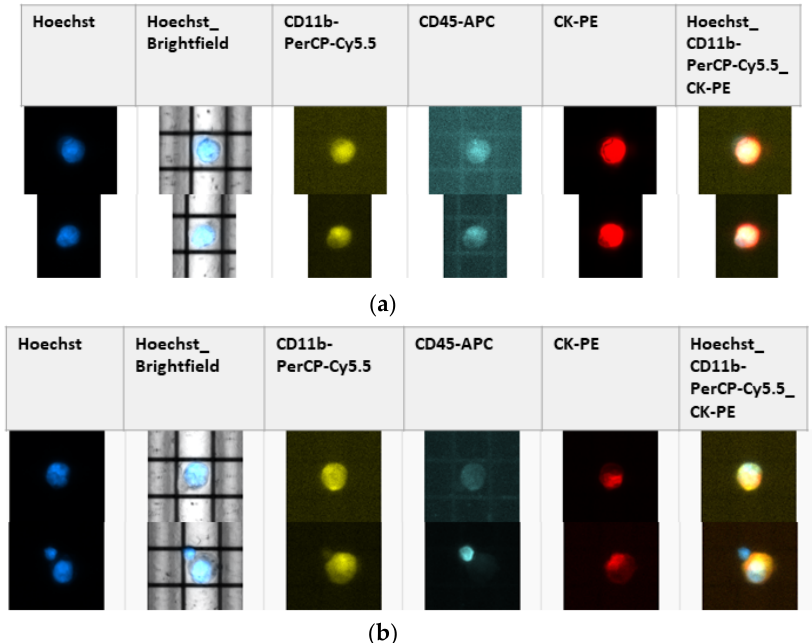
Figure A3. Final CD11b- staining applied in two different healthy donor (hd) samples with spiked OVCAR-3 cells. Fluorescence panel generated with the DEPArray™ NxT. ( a ) Two OVCAR-3 cells Hoechst pos , CD11b pos , CD45 neg , CK pos in hd3. ( b ) Two OVCAR-3 cells Hoechst pos , CD11b pos , CD45 neg , CK pos in hd4, the latter cell is accompanied by a CD45 pos leucocyte.